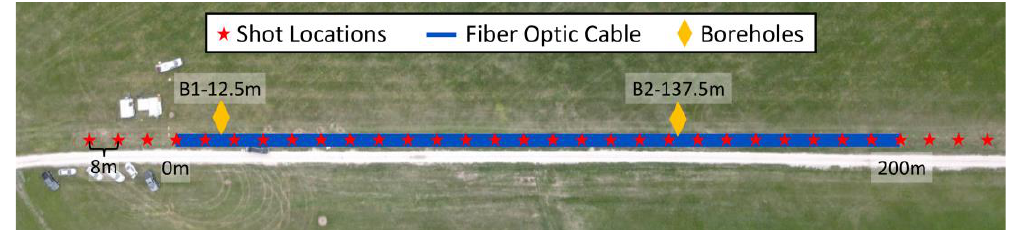
Figure 1. Aerial view of the Hornsby Bend test site showing the layout of the DAS fiber optic cable, vibroseis shot locations, and boreholes. vibroseis shot locations, and